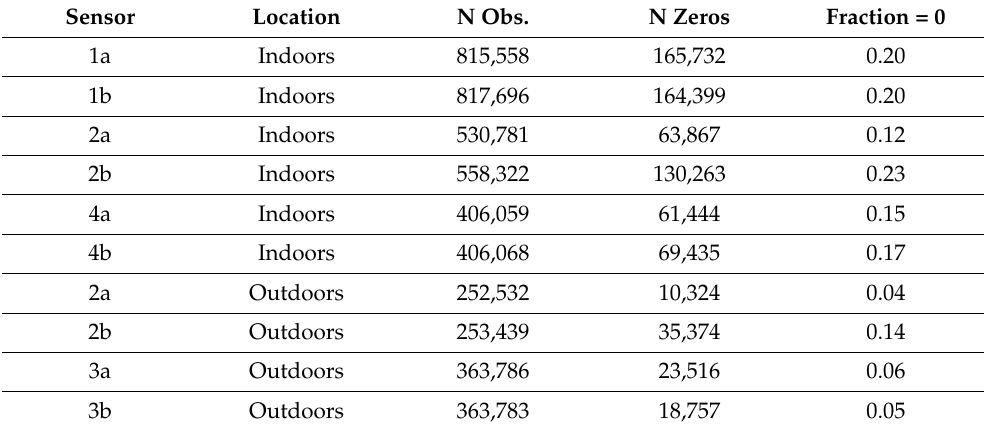
Table 2. Number of PM 2.5 concentrations reported as zero by the Plantower CF1 algorithm for monitors 1 and 2 over a 3 year period and monitors 3 and 4 over an 18 month